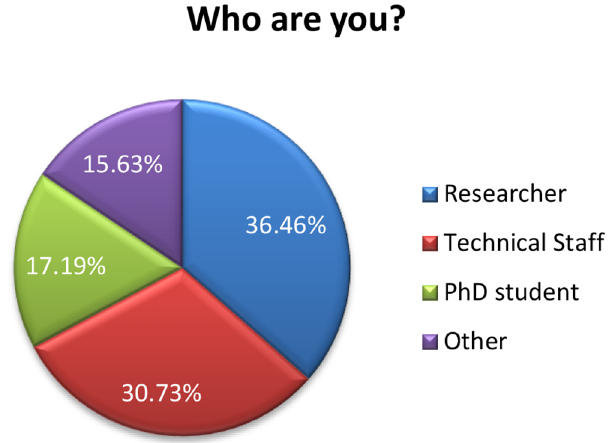
Fig. 1. Participants in the